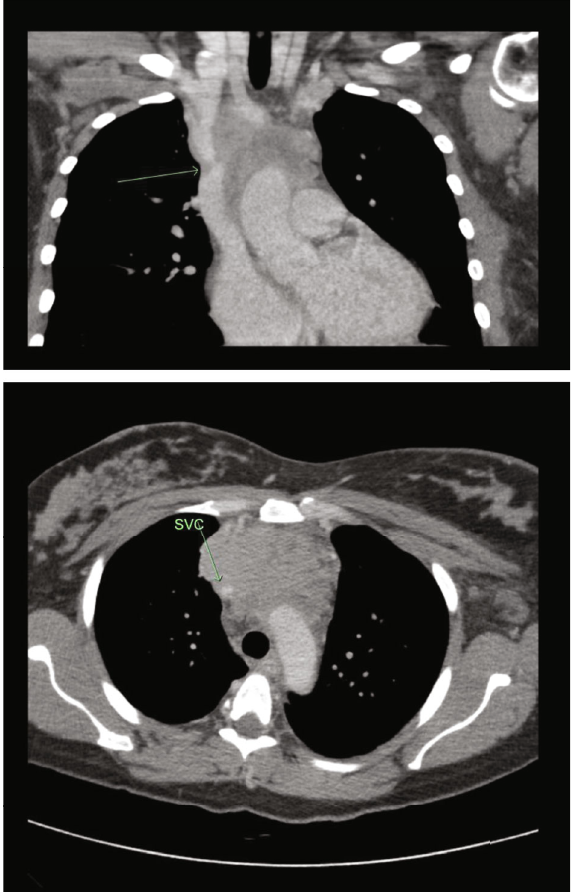
Figure 1: CT scan on presentation showing a mediastinal mass and concomitant obstruction of the SVC to 1mm in diameter (green